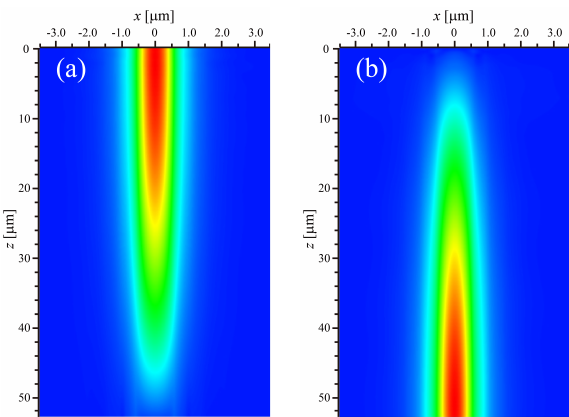
Figure 5. Propagation behavior of a TM mode incident light in the PC along z direction at λ = 1.55 µ m.